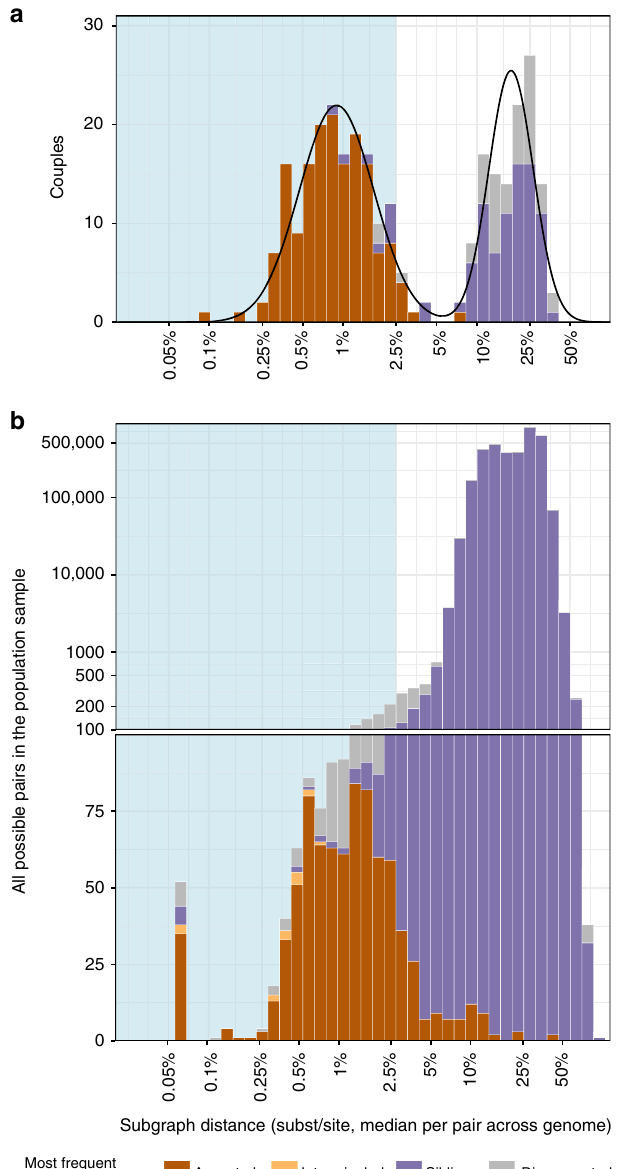
Fig. 3 Deep-sequence phylogenetic data in the population-based